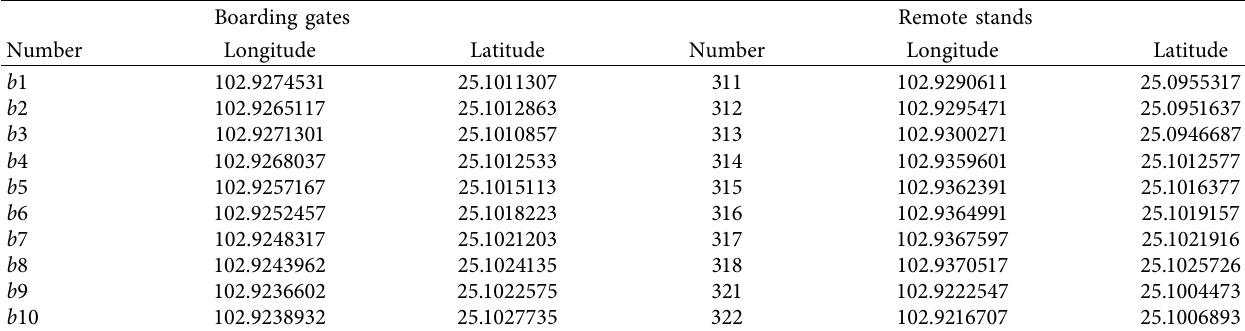
Table 4: Latitude and longitude information of service point (partial).